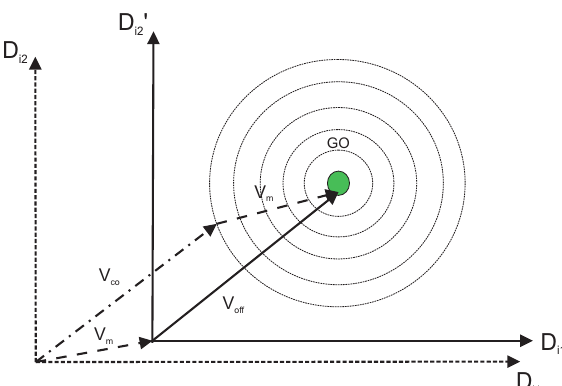
Figure 7. Candidate offspring generation with mutation vector.